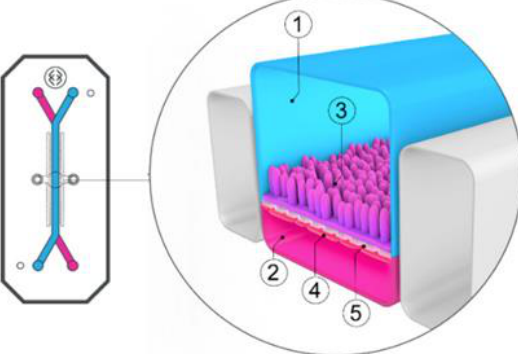
Figure 9. Organ-on-a-chip. Duodenum Intestine-Chip from Emulate, including its top view ( left ) and vertical section ( right ) showing: the epithelial (1; blue) and vascular (2; pink) cell culture microchannels populated by intestinal epithelial cells (3) and endothelial cells (4), respectively, and separated by a flexible, porous, ECM-coated polydimethylsiloxane (PDMS) membrane (5). Adopted from [158], eLife, 2020.